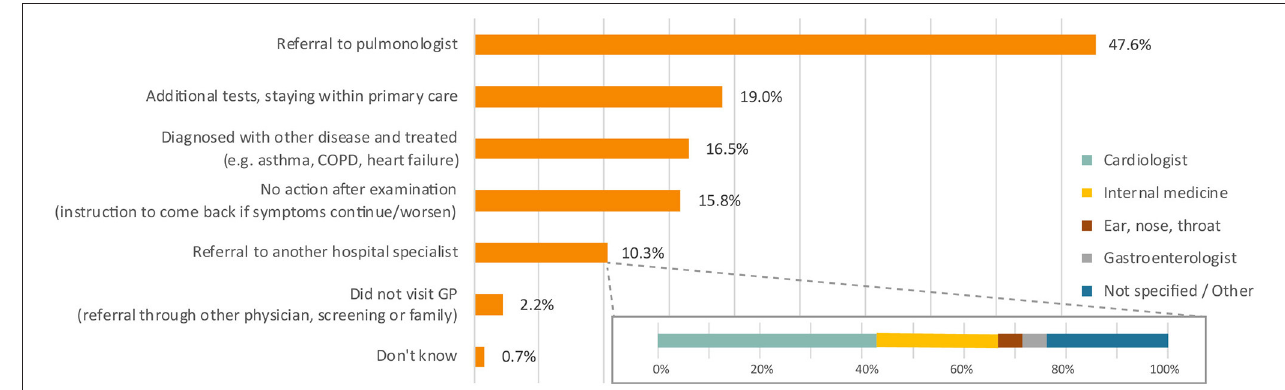
FIGURE 3 | Action of physician at first visit primary care. Percentages do not add up to 100% as more than one response was allowed. Total responses n = 306. COPD, chronic obstructive pulmonary disease; GP, general practitioner.